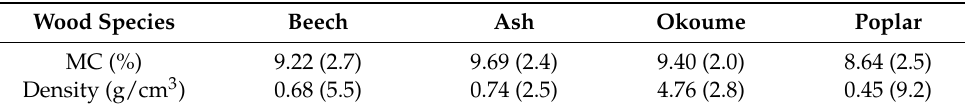
Table 1. Density and moisture content of four wood species evaluated.